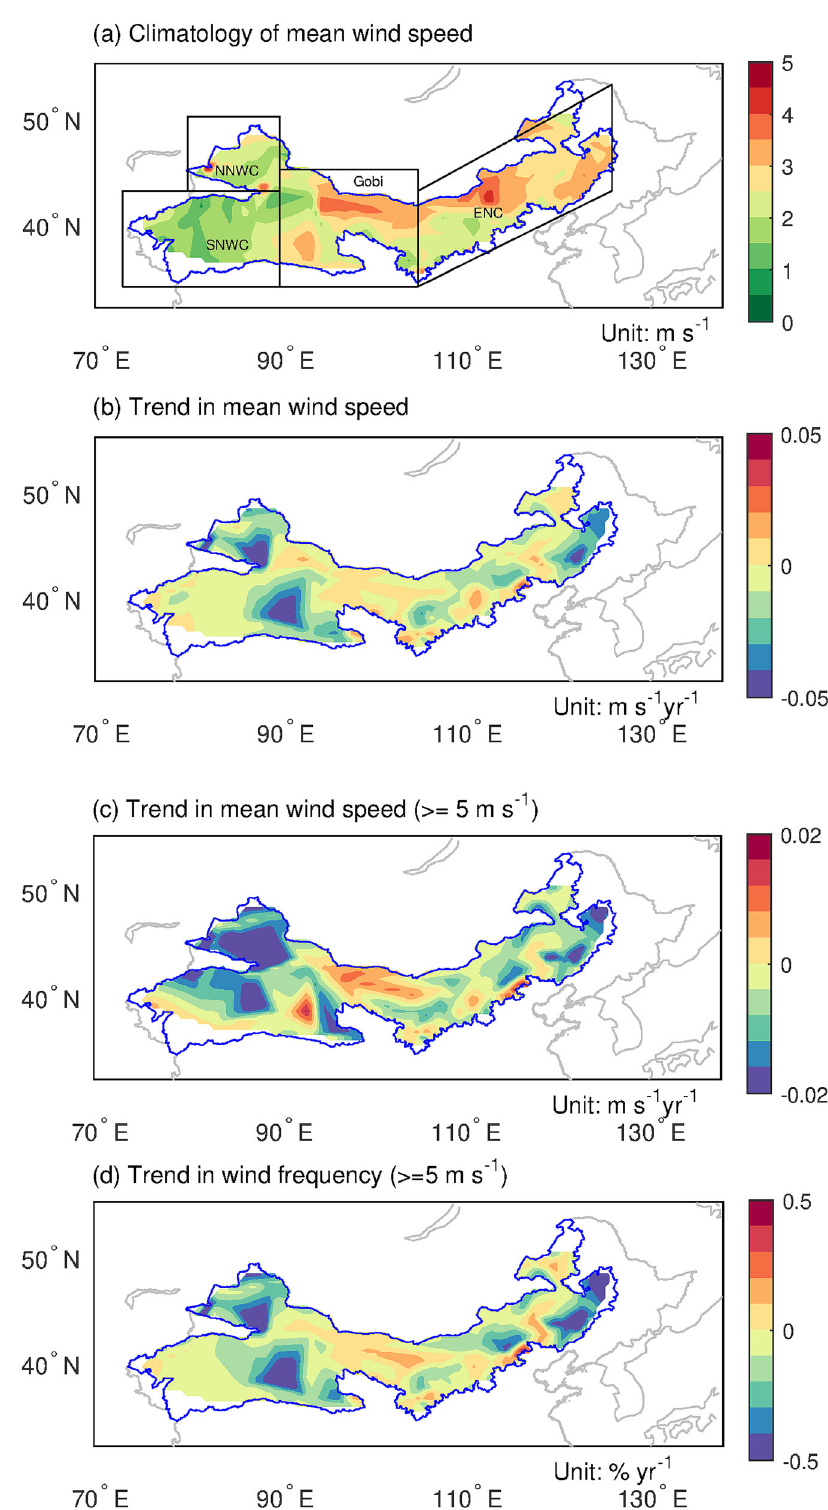
Fig. 2 Spatial distribution of climatological wind speed ( a ), trends in mean wind speed ( b ), mean wind speed of heavy wind ( c ), and heavy wind frequency ( d ) in spring over northern China during 1981–2016. The southern Northwest China (SNWC), northern Northwest China (NNWC), Gobi Desert, and eastern northern China (ENC) are enclosed by solid lines in ( a